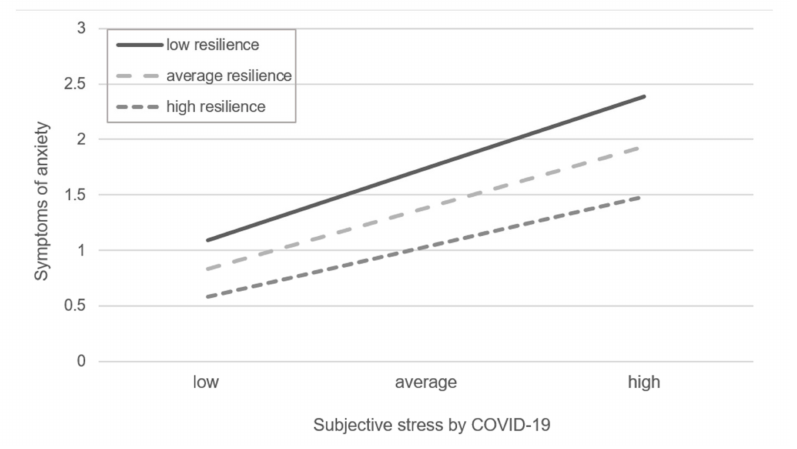
Figure 1. Simple slope analysis for low resilience (1 SD below the mean), average resilience and high resilience (1 SD above the